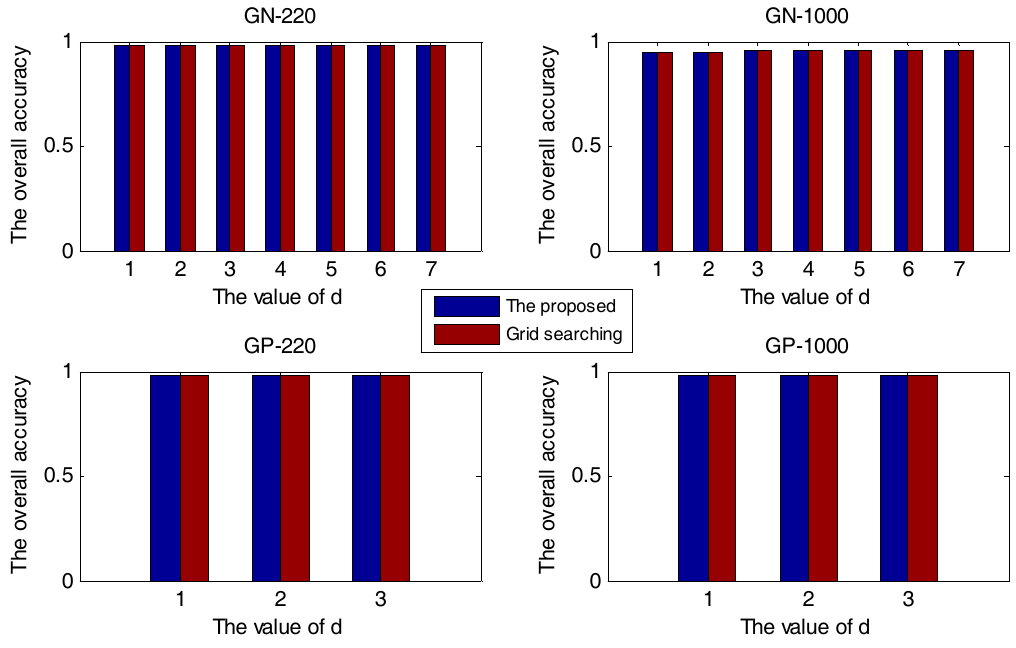
Figure 1. The overall accuracy versus d for four sample sets.